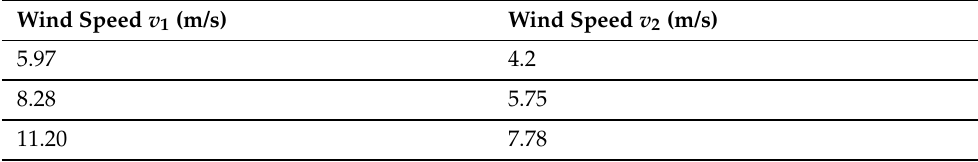
Table 6. Values of wind speed before and after the